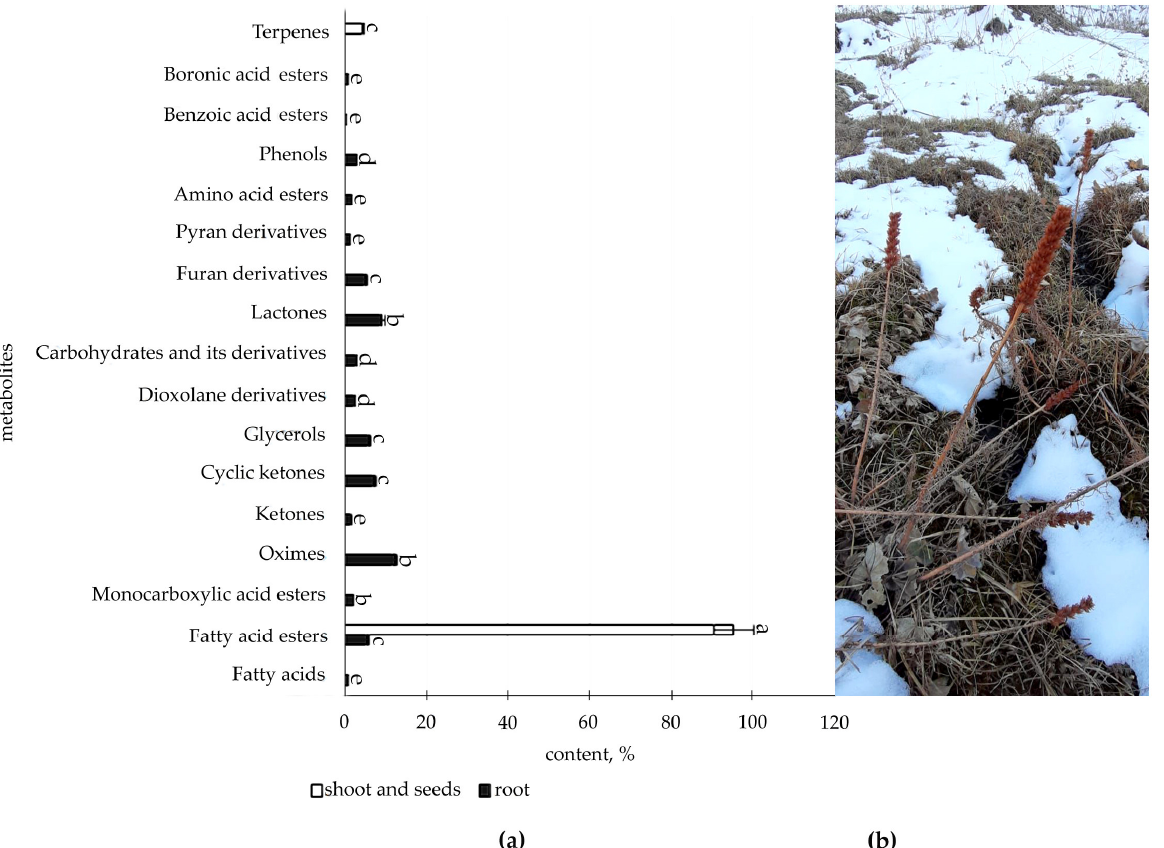
Figure 4. ( a ) Content of secondary metabolites classes of adult plants R. semenovii under ripening of seeds, %. Values presented are means (±SD). Different letters above the bars represent significant differences at p ≤ 0.05, n = 3 plants in each of 3 replicates for all treatments; ( b ) adult plants R. semenovii with seeds.